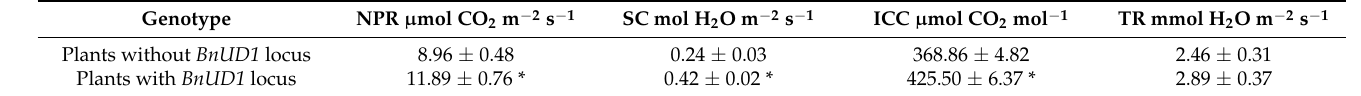
Table 5. Photosynthetic indicators in leaves of plants with BnUD1 locus and that without BnUD1